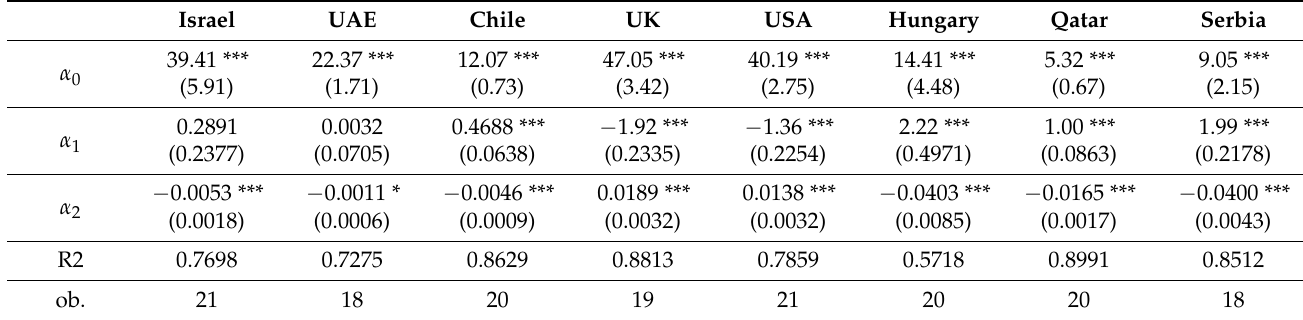
Table 3. The regression result of Equation